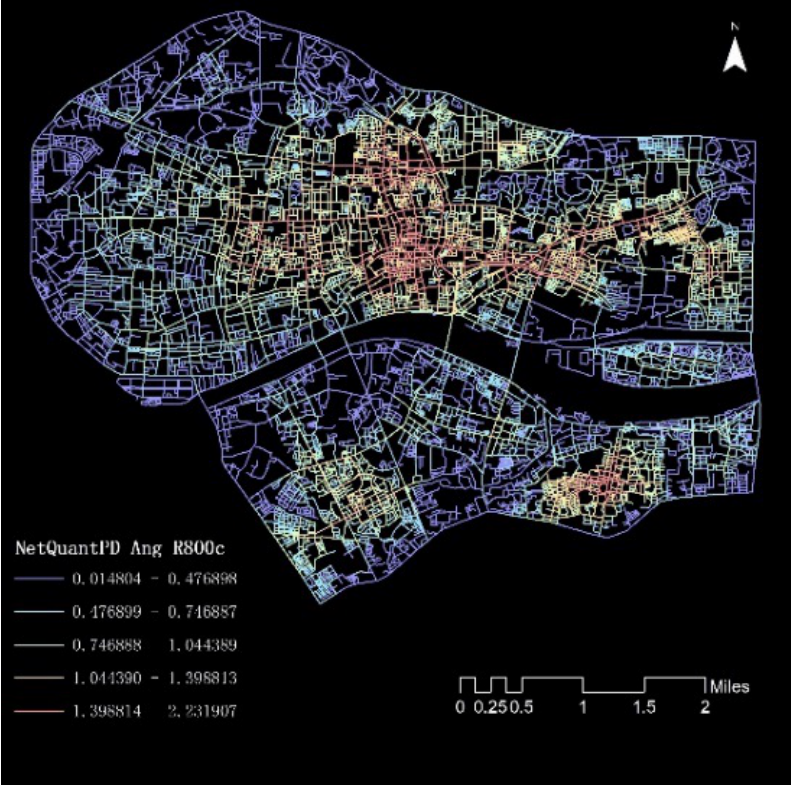
Fig. 4 The regional closeness of 800m